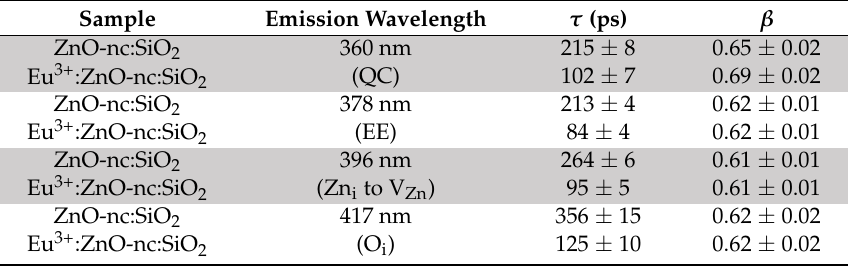
Table 1. The decay time ( τ ) and stretching exponential coefficient ( β ) values for the various ZnO-nc emission centers obtained from the time-resolved photoluminescence (TRPL) spectra of the samples with and without Eu 3+ ions (Eu 3+ :ZnO-nc:SiO 2 and ZnO-nc:SiO 2 samples, respectively).